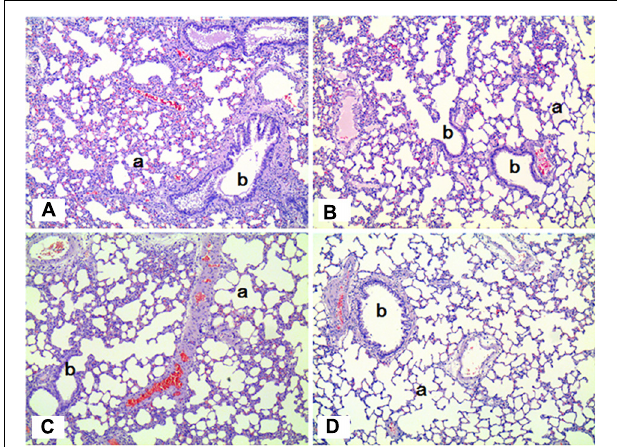
FIGURE 7 | Body weight changes in rats exposed to SM and PG mixture. The male rats inhaled aerosolic SM and PG for 2 weeks. The analysis of aerosolic particle size distribution. Mean ± SE (Student’s t -test, ∗ P < 0.05, ∗∗ P < 0.01, and ∗∗∗ P < 0.001 vs.